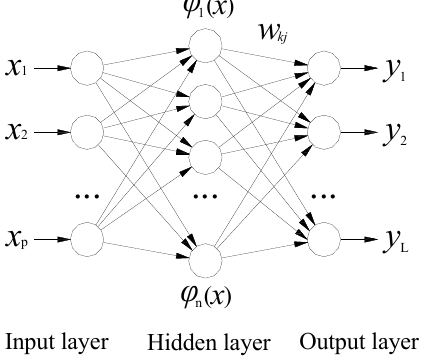
Figure 15. The structure of radial basis function neural network.